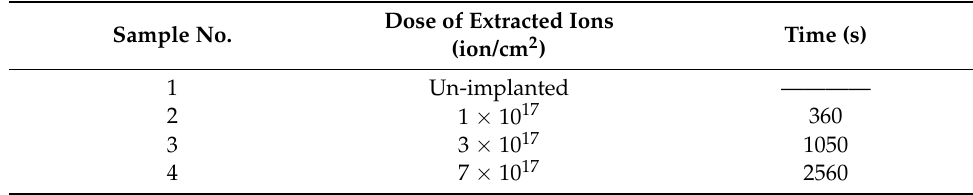
Table 1. The argon ion implantation process parameters. Sample No. Dose of Extracted Ions (ion/cm 2 )